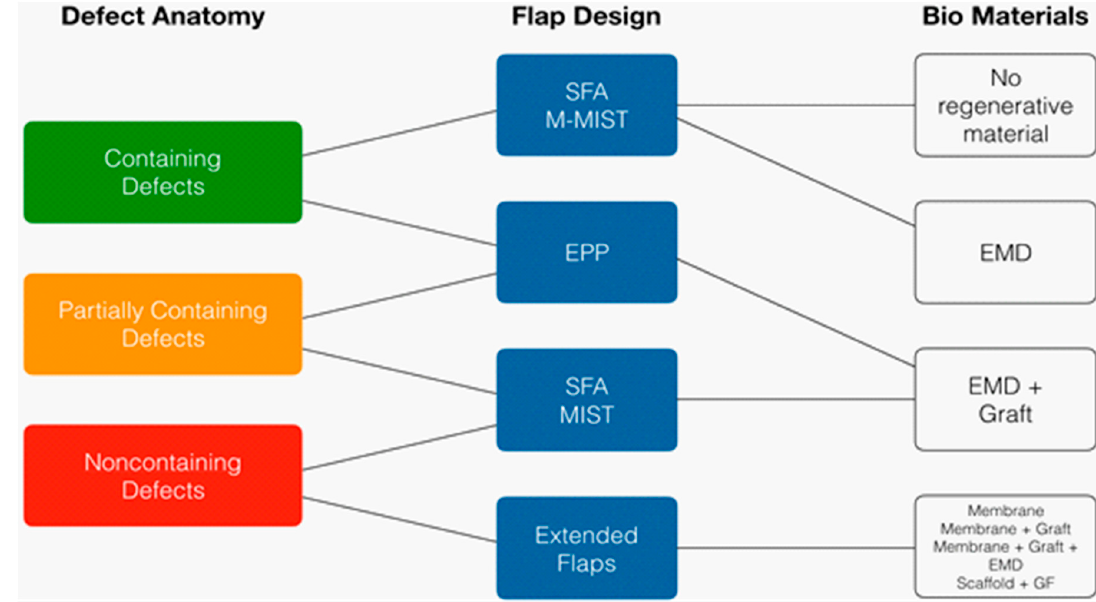
Figure 4. Choice of flap design and biomaterials according to defect morphology. SFA: Single flap approach, M-MIST: Modified minimally invasive surgical technique, EPP: Entire papilla preservation, MIST: Minimally invasive surgical technique.